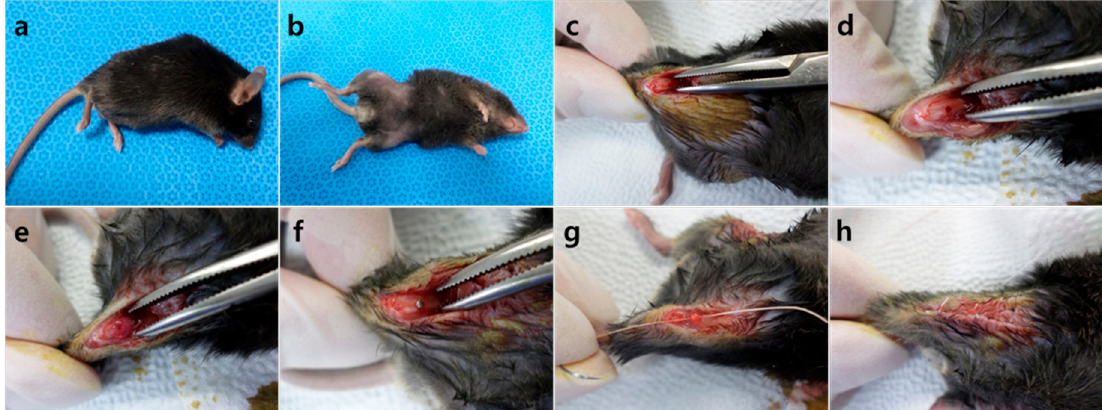
Figure 4. Surgical procedure of the implant. ( a ) Anesthetized mouse, ( b ) skin preparation, ( c ) incision, ( d ) preparation of the implant site, ( e ) gel injection, ( f ) placement of the implant, ( g ) closure of the surgical site layer by layer, ( h ) post surgery.